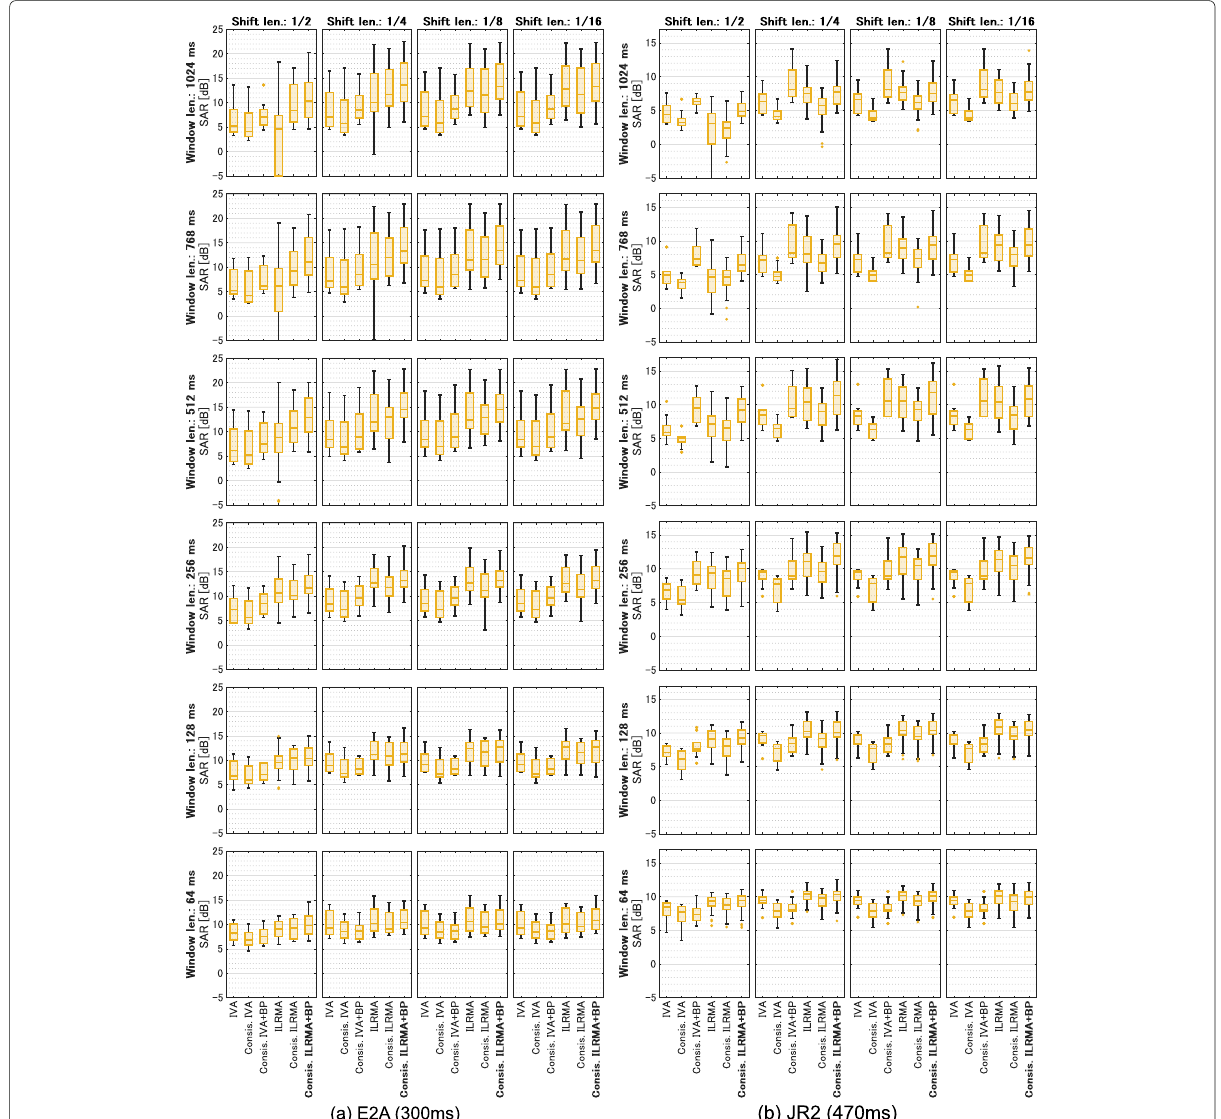
Fig. 24 Average SAR for synthesized music mixtures (music 1–10) with a E2A and b JR2 , where Blackman window is used in